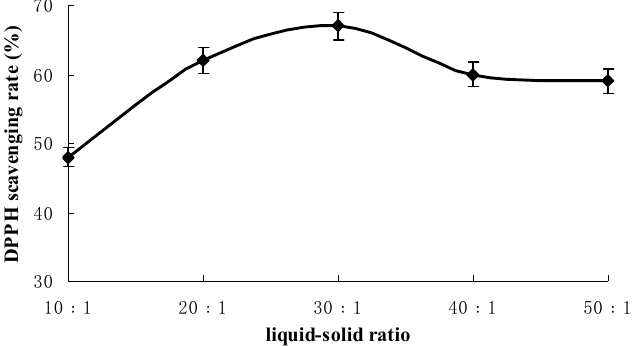
Figure 2. The influence of liquid-solid ratio on antioxidant activities of extraction.